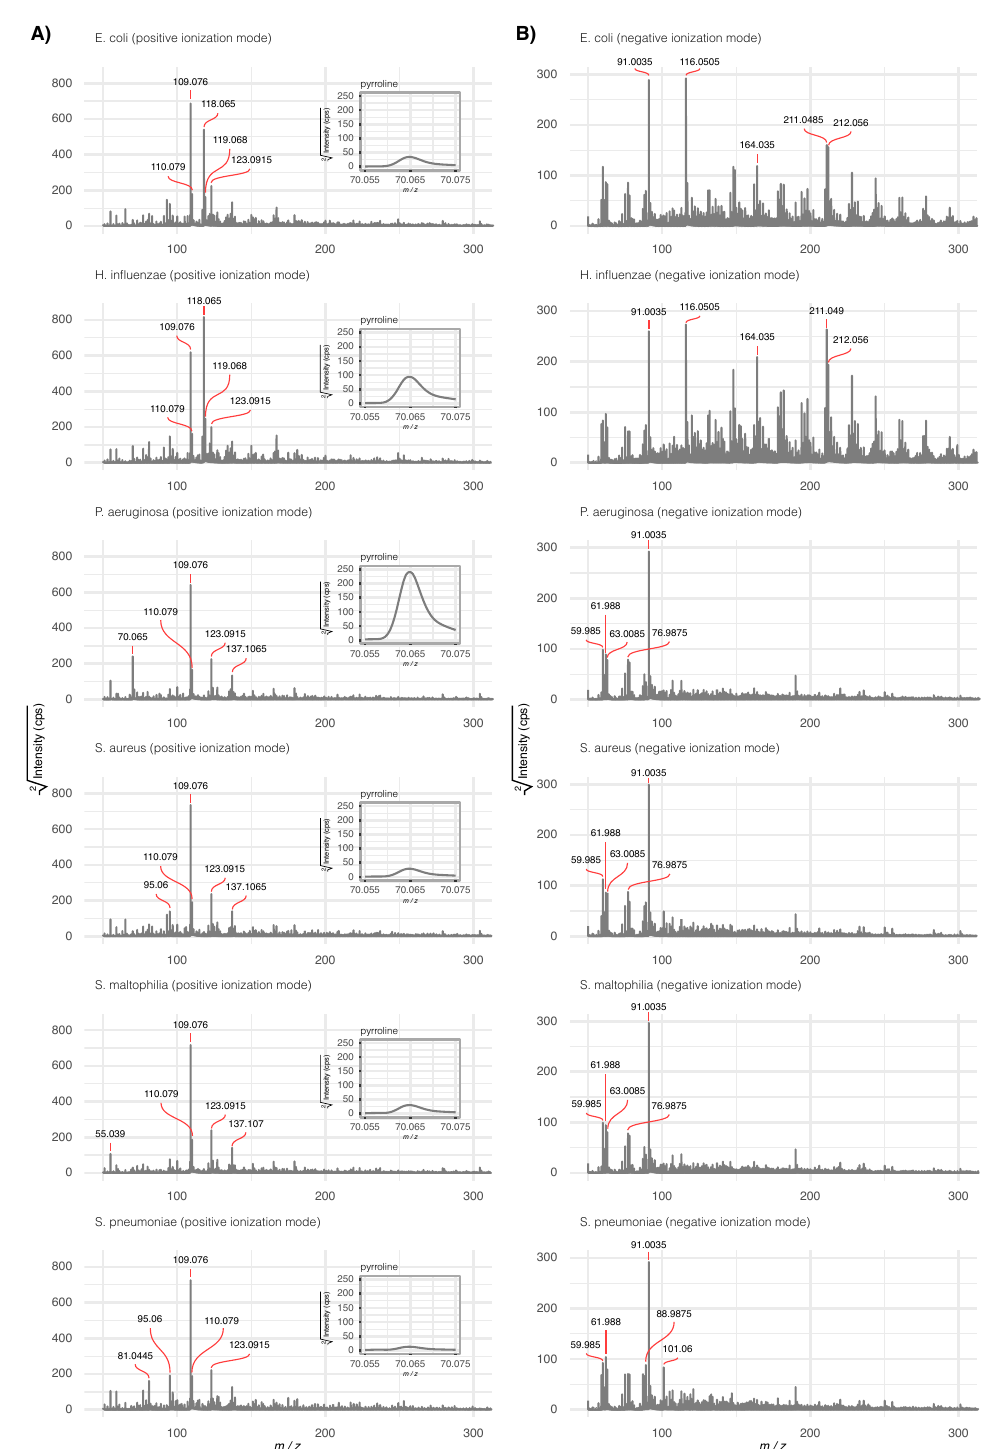
Figure 1. Average mass spectra (averaged over scans and repetitions) for the six pathogens in positive ( A ) and negative ( B ) ionization mode. For better visibility, the intensity scale is square root transformed and only the 50–300 m / z range is depicted. The five most intense signals are labeled. As an example of a characteristic feature for P. aeruginosa , a zoomed region corresponding to pyridine [ M + H ] + is shown in positive